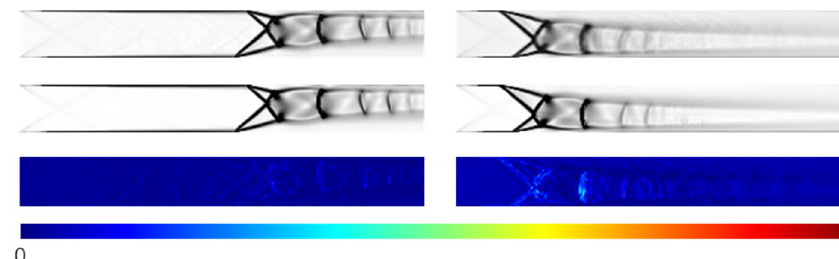
Fig. 9 Absolute error color map of flow field reconstruction